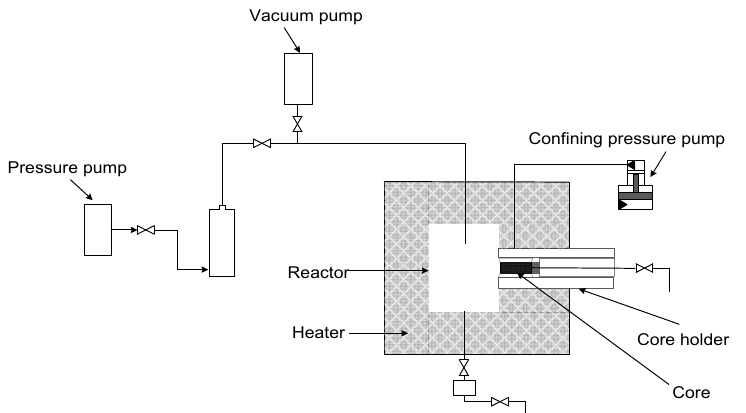
Figure 1. Diagram of experimental equipment for water forced imbibition of water in shale.